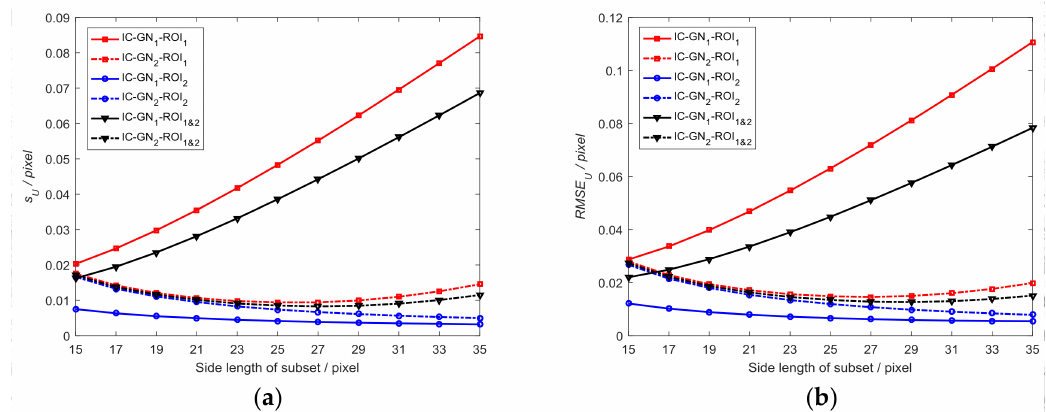
Figure 3. Measured displacement errors ( s U , RMSE U ): ( a ) Standard deviation as a function of side length of subset; and ( b ) RMSE as a function of side length of